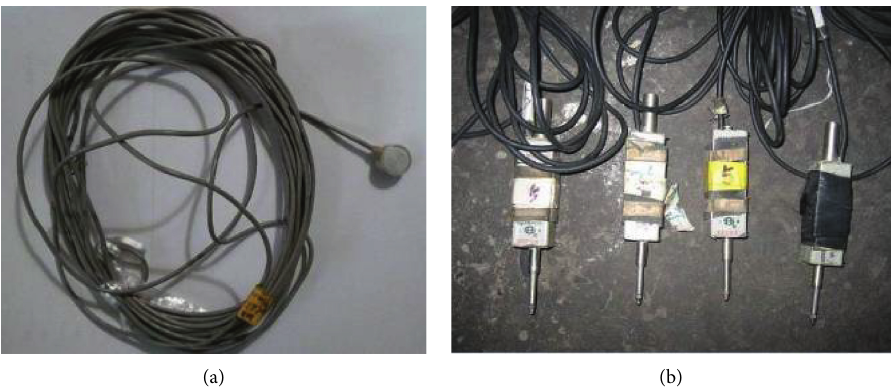
Figure 4: Test sensors. (a) DYB-1 micropressure sensor. (b) YHD displacement sensor.